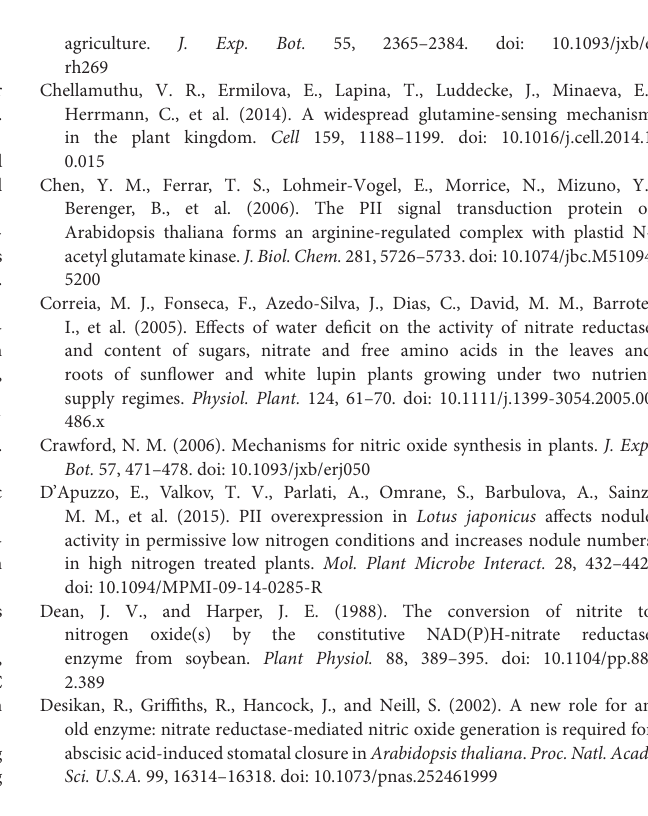
Figure S1 | Sequence of the 980bp 5 ′ UTR region of the LjGLB1 gene. Putative biding sites for Dof and NF-WA transcriptional factors are indicated in bold and italic, respectively. Figure S2 | Analysis of stomata aperture in A. thaliana Columbia ecotype and PIIS2 plants. (A) Effect of 10 µ M ABA on stomata closure. Epidermal strips from detached leaves were exposed to light for 3 h and then treated with (black bars) and without ABA (white bars) for an additional hour. Asterisks indicate significant differences between ABA-treated and un-treated plants ( p < 0.0001; VassarStats analysis of variance program). (B) Stomata aperture in detached leaves isolated at the 6th hour of the daily light period. Columbia wild type and PIIS2 plants are indicated. Bars represent the average and SE for three independent experiments. For each treatment, at least 60 stomatal apertures were measured and data presented are the means of at least 3 independent experiments (2 leaves per